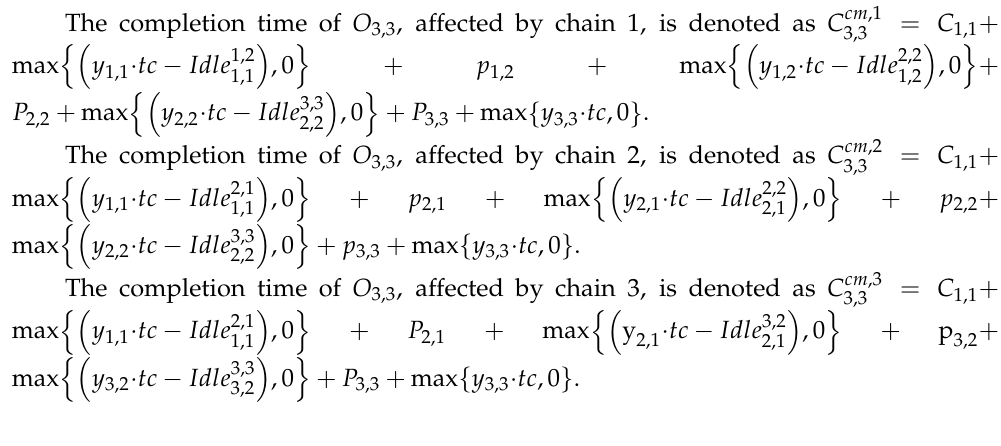
Figure 3. A feasible schedule that has suffered from machine breakdowns.